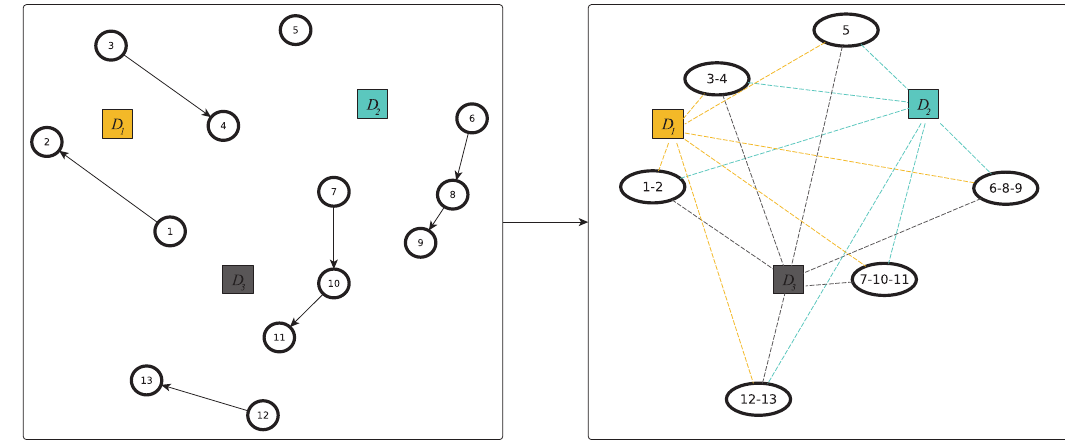
Fig. 6. Supernodes corresponding to travel itineraries (GAP)